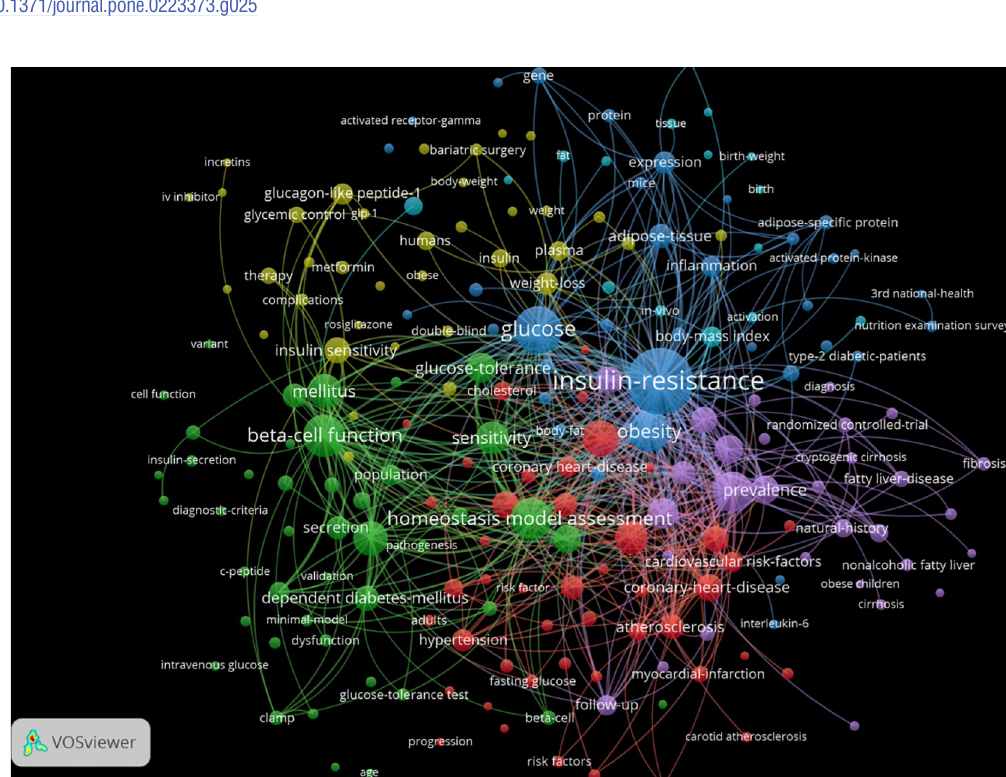
Fig 26. Concept co-occurrence map of the 500 most highly cited papers that cite the Matthews et al SB-SNPR (co- occurrence threshold = 5).